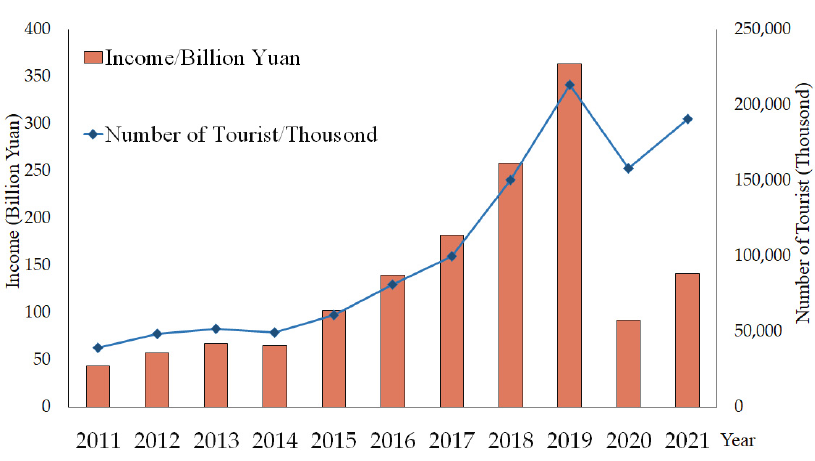
Figure 6. Tourism income and the number of tourists in Xinjiang from 2011 to 2021.